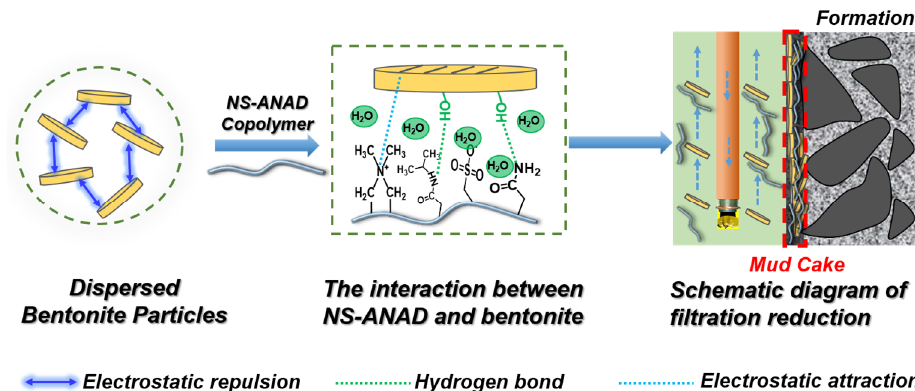
Figure 8. Schematic illustration on the mechanism of NS-ANAD co-polymer in enhancing the rheology and filtration performance of drilling fluid.